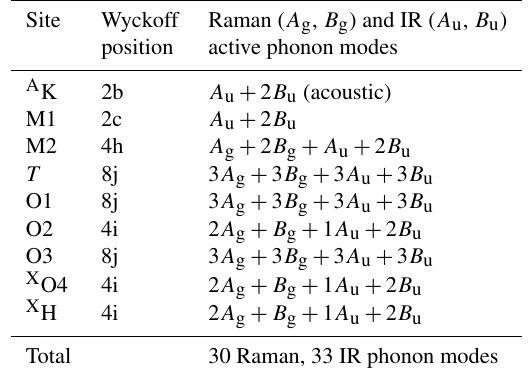
Table 2. Group-theory analysis for the monoclinic C2/m space group of